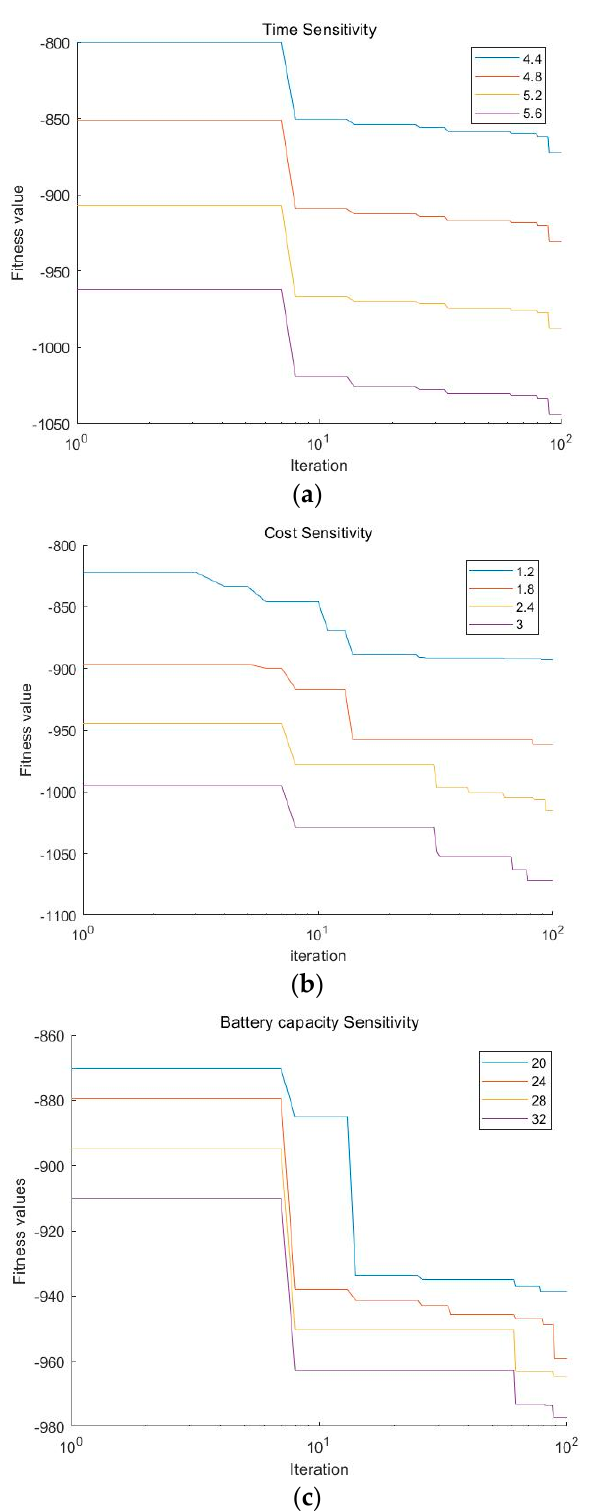
Figure 4. ( a ) Sensitivity analysis of time; ( b ) Sensitivity analysis of cost; ( c ) Sensitivity analysis of battery capacity.